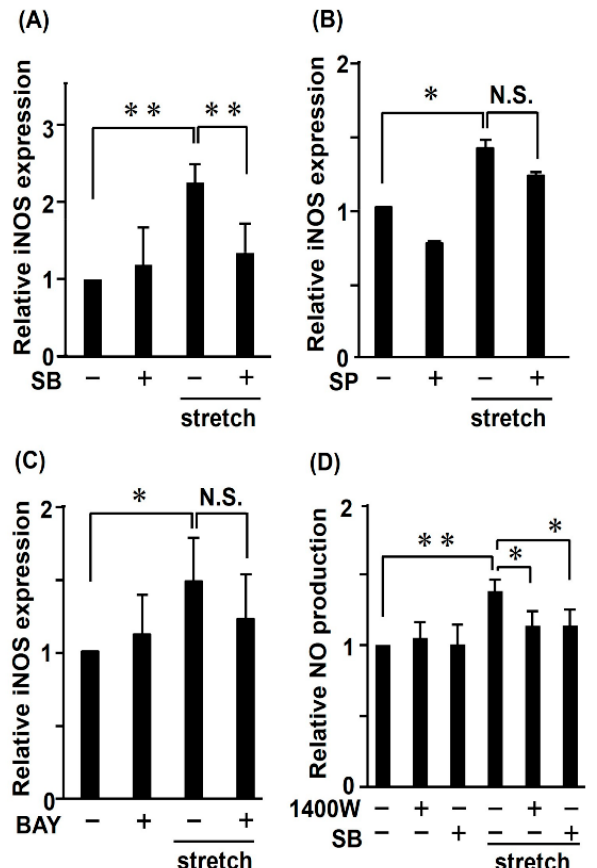
Figure 3. Induction of inducible nitric oxide synthase (iNOS) and NO in RASMCs subjected to CMS. RASMCs were incubated with SB203580 (SB, 20 μ M, 20 min) ( A ), SP600125 (SP, 20 μ M, 20 min) ( B ), BAY11-7082 (BAY, 2.5 μ M, 20 min) ( C ), or 1400 W (50 nM, 1 h) ( D ) followed by CMS for 4 h. Cells were harvested and analyzed by real-time RT-PCR with specific primers for iNOS ( A – C ) and the medium was analyzed for NO production by ELISA ( D ). Data are means ± SD ( n = 9); * p < 0.05 and ** p < 0.01 versus CMS control; N.S. indicates no significant difference.